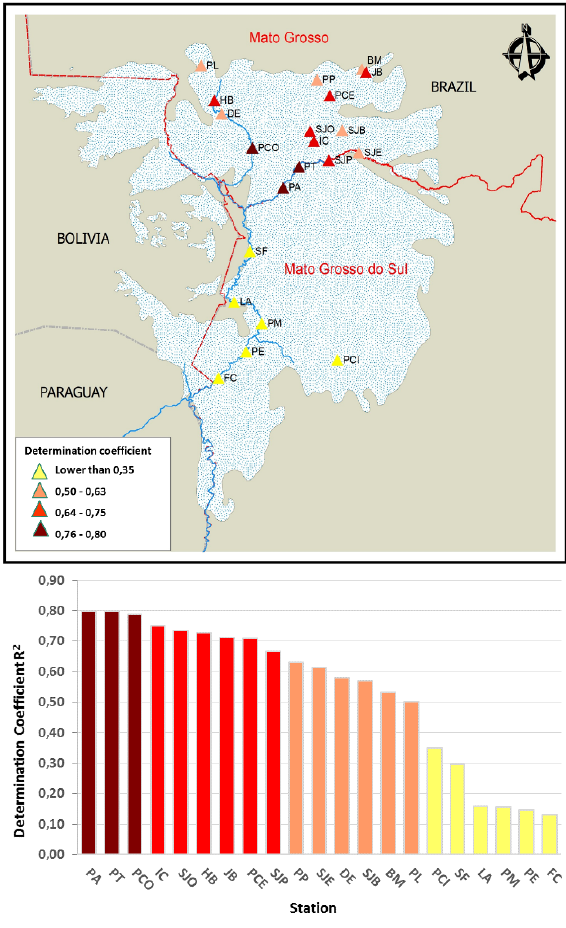
Fig. 6. Determination coefficients ( R 2 ) for the Pantanal stations and its spatial distribution: in yellow, the ones corresponding to Mato Grosso do Sul State (downstream), and the rest of the palette, to the Mato Grosso ones (headwaters).